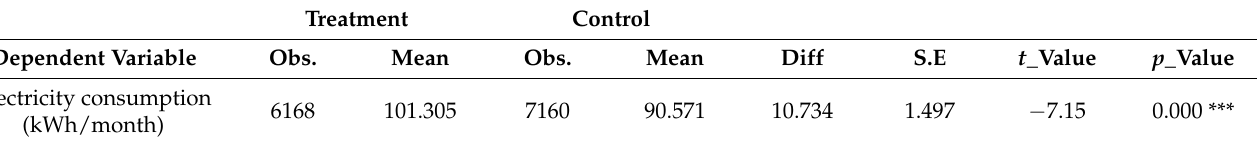
Table 3. After treatment comparison between the groups.